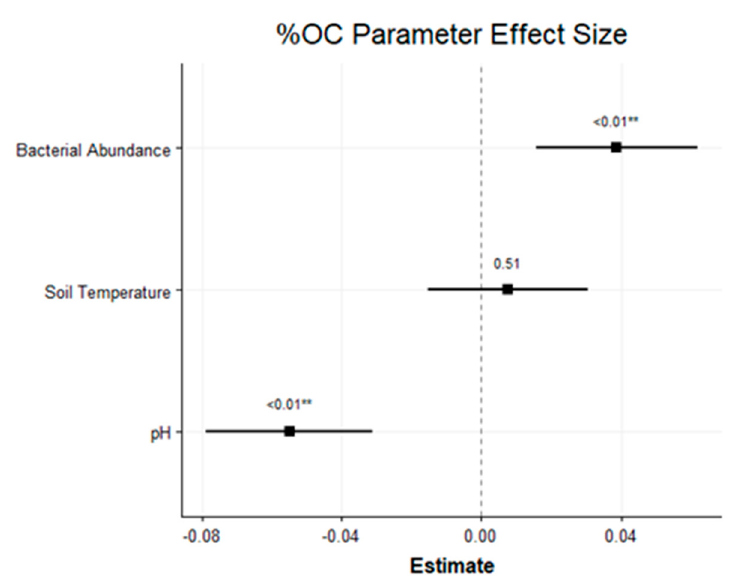
Figure 3. Percent Organic Carbon Parameter Effect Size. Double asterisk (**) denotes a significant